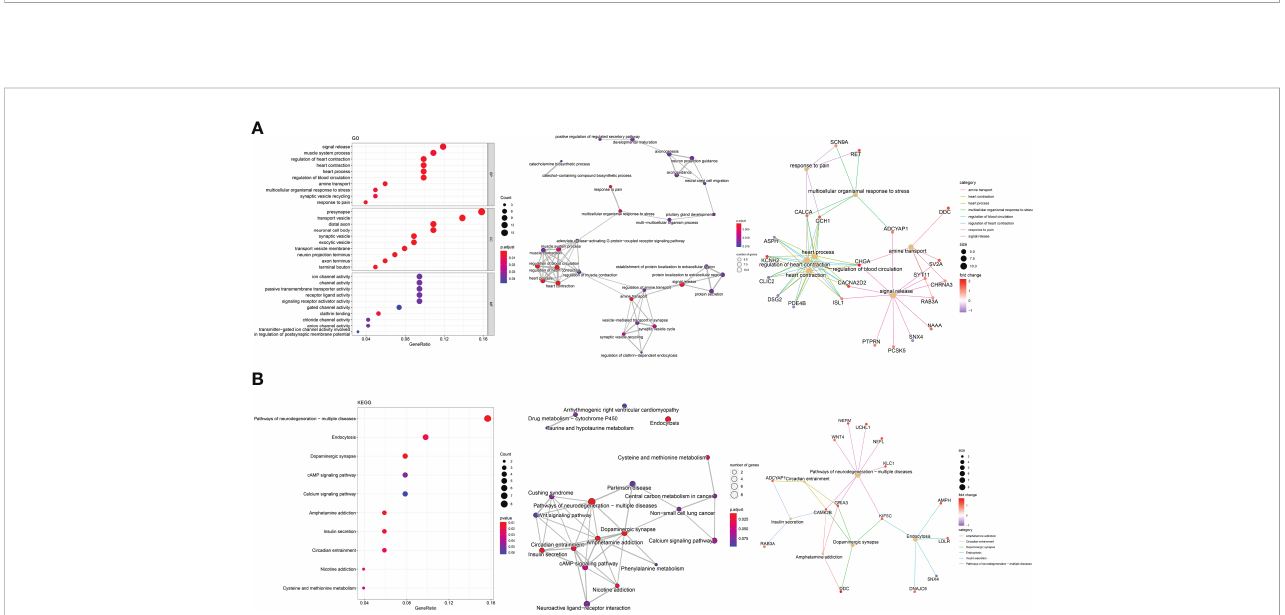
FIGURE 3 Enrichment analysis of DEGs exclusive for MTC. (A) The top 10 terms, enrichment map and gene-concept network by gene ontology (GO) analysis. (B) The top 10 pathways, enrichment map and gene-concept network by Kyoto Encyclopedia of Genes and Genomes (KEGG) pathway